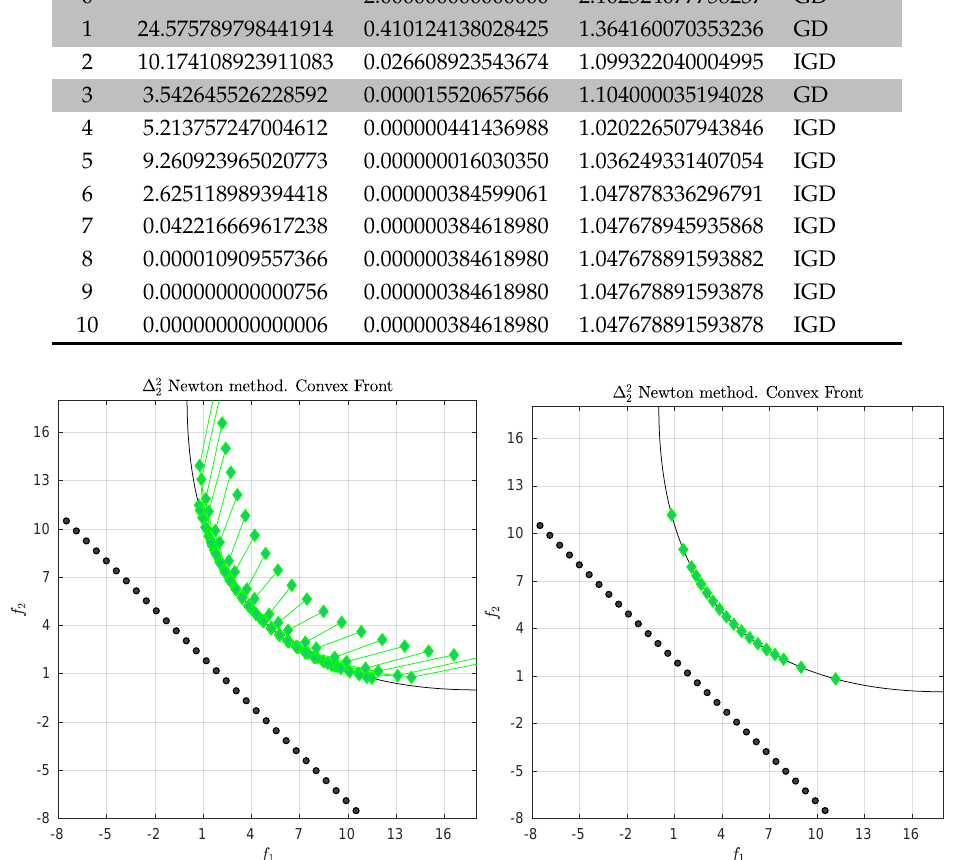
Figure 11. ( Left ) application of the ∆ 2 -Newton method on BOP (27). ( Right ) the final